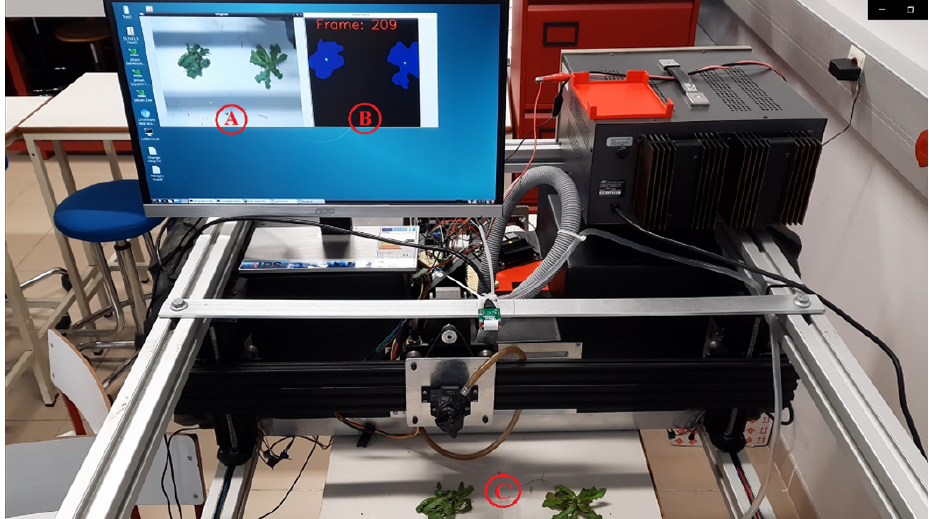
Figure 13. Real-time application result: segmentation of weeds (general view), ( A ) An image with two weeds is shown; ( B ), two weeds were segmented with a high-quality border corresponding to the image in ( A ); ( C ) shows the weeds in the field of view of the camera and the spray